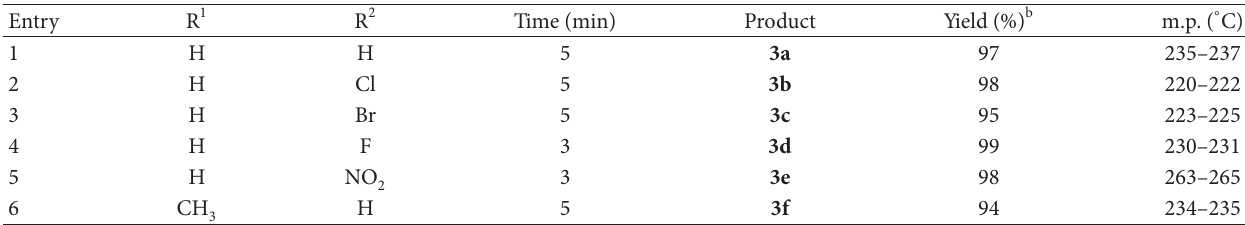
T 2: e Knoevenagel condensation of isatins with malononitrile catalyzed by I